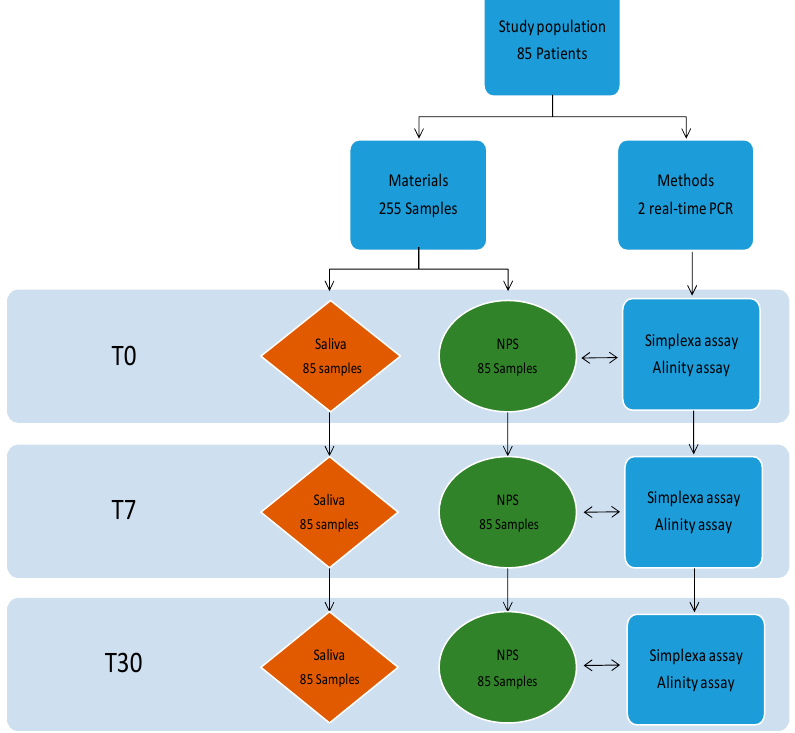
Figure 4. Schematic work fl ow of the study.